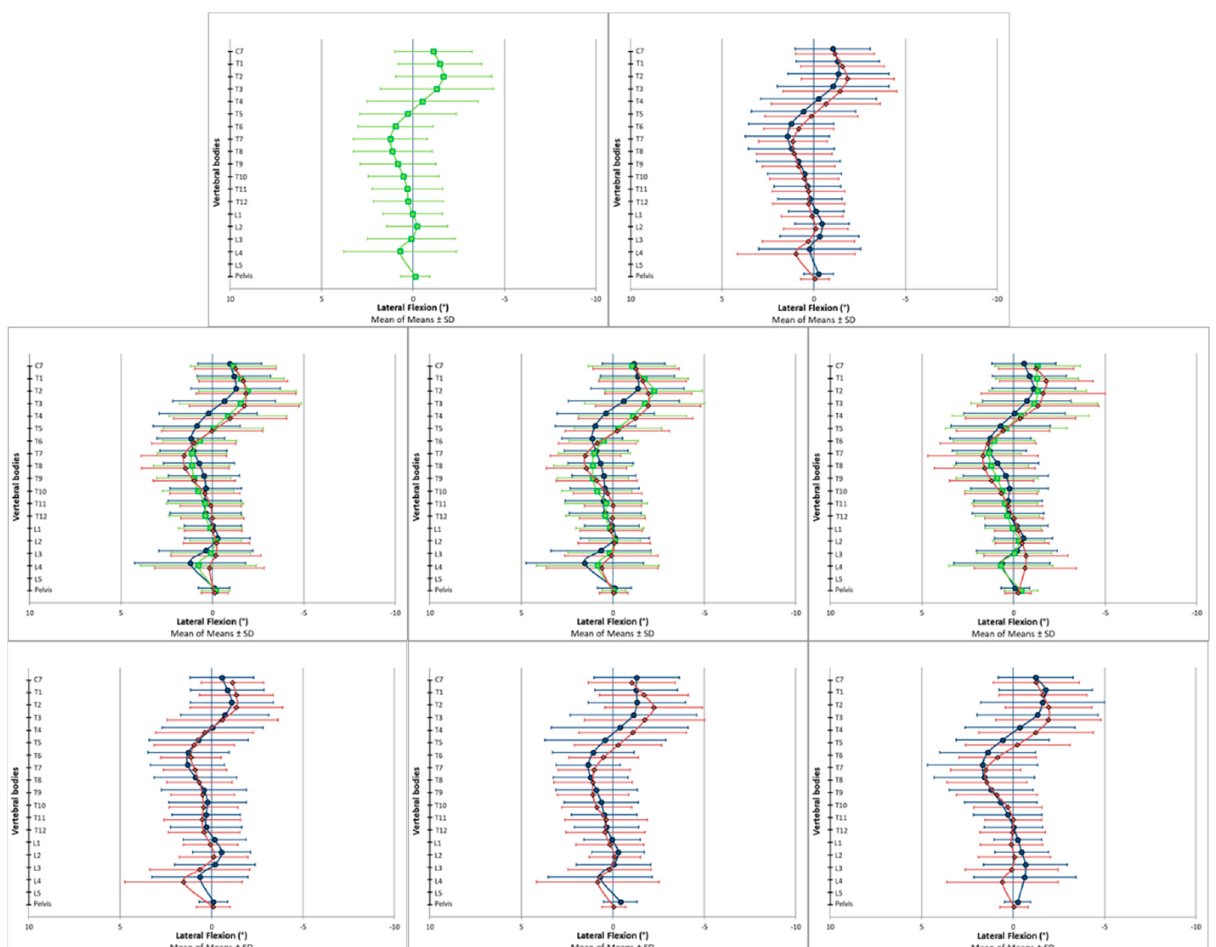
ture: all female ( ◆ , red) and all male ( ● , blue) participants). Middle row (left picture: all participants of the respective age cohorts: young ( ● , blue), middle ( ◼ , green) and old ( ◆ , red); middle picture: all female participants of the respective age cohorts: young ( ● , blue), middle ( ◼ , green) and old ( ◆ , red); right picture: all male participants of the respective age cohorts: young ( ● , blue), middle ( ◼ , green) and old ( ◆ , red)). Lower row (left picture: all young female ( ◆ , red) and all young male ( ● , blue) participants; middle picture: all middle-aged female ( ◆ , red) and all middle-aged male ( ● , blue) participants; right picture: all old female ( ◆ , red) and all old male ( ● , blue) participants).